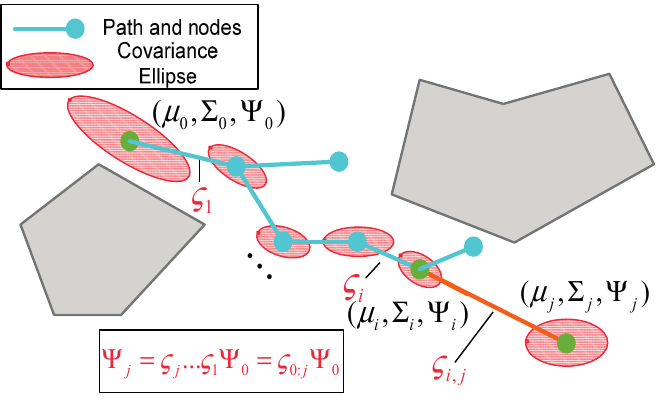
Figure 1. Linear covariance prediction procedure using the transfer